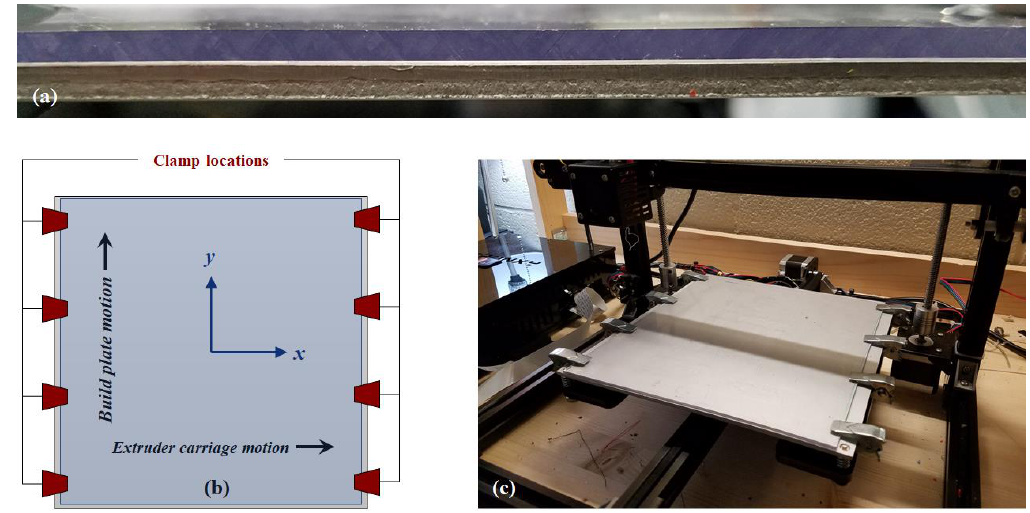
Figure 4. Proposed AL-PC print bed ( a ); clamping locations ( b ); and configuration ( c ).